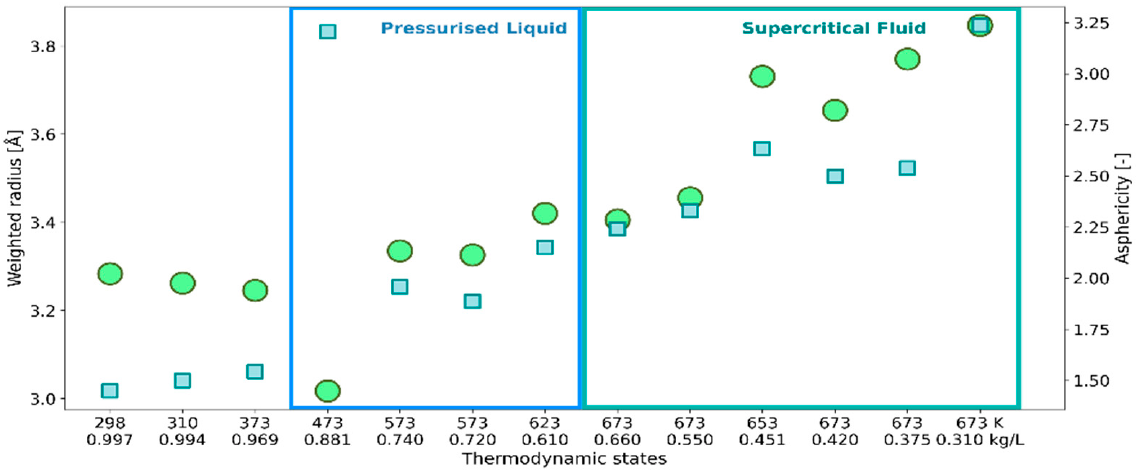
Figure 3. Face-weighted radius R w (circles, left axis) and asphericity factor α (squares, right axis) of VP representing • OH aq at the thermodynamic states defined by temperature and density.